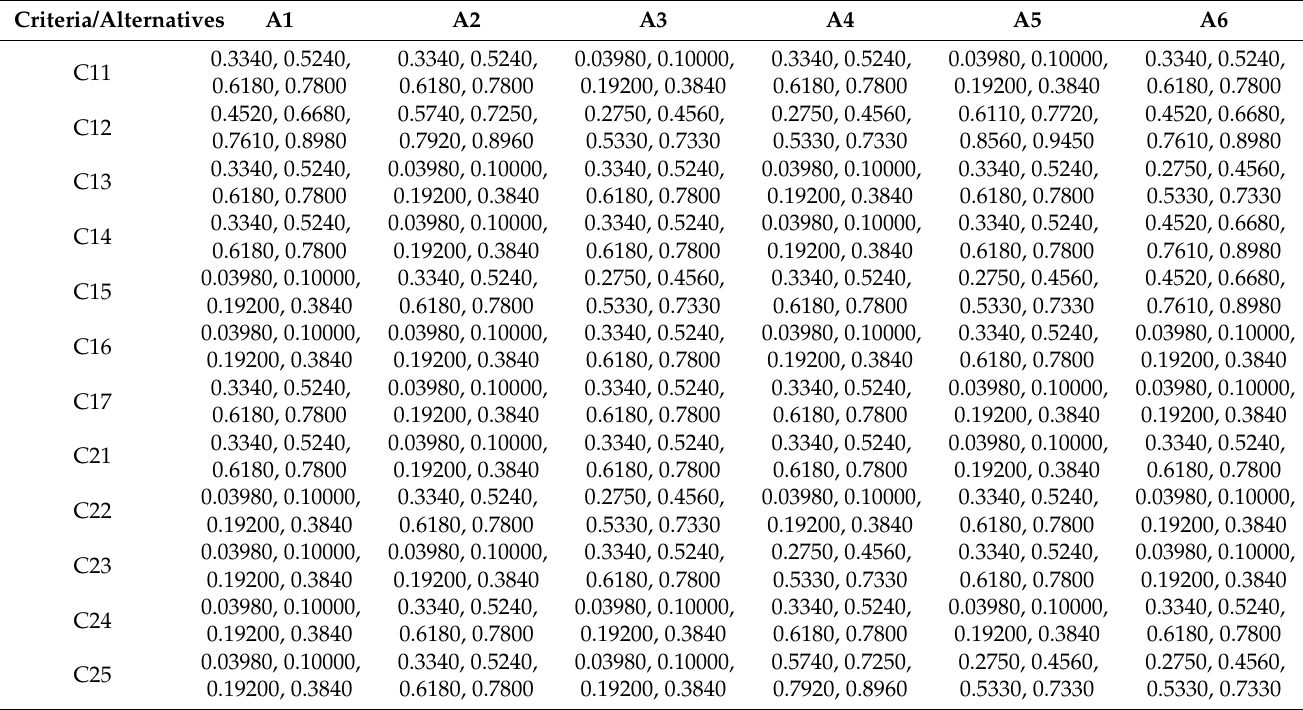
Table 7. The Normalized Fuzzy-Decision